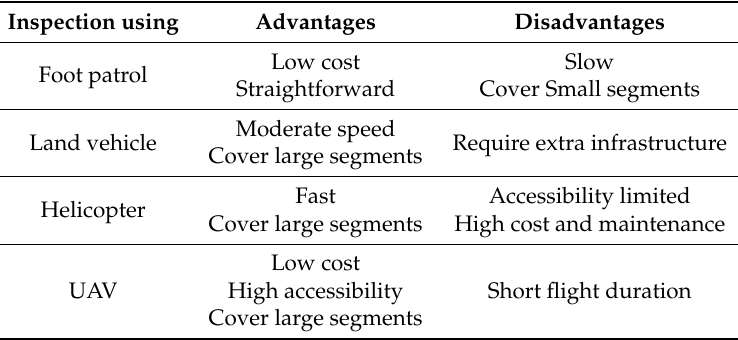
Table 2. A comparison between different inspection